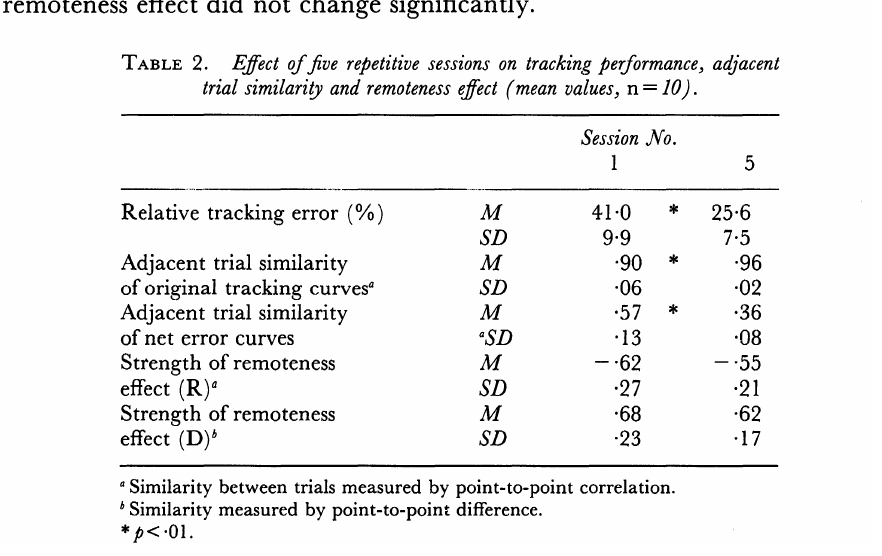
TABLE 2. Effect of five repetitive sessions on tracking performance, adjacent trial similarity and remoteness effect (mean values, n = 10) .